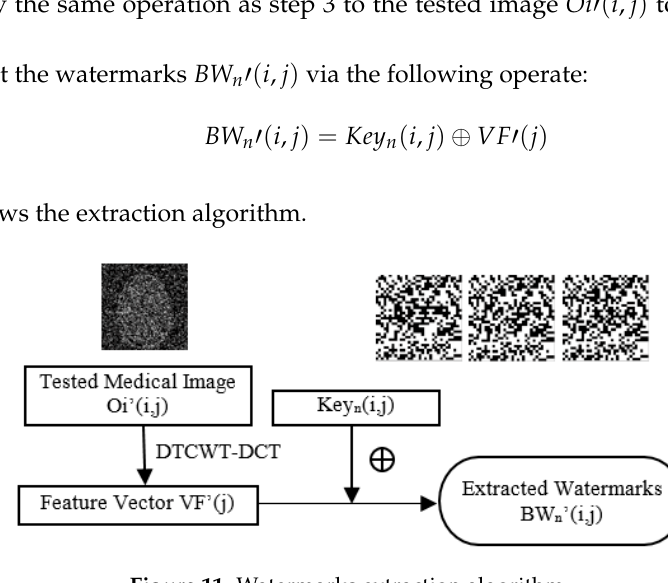
Figure 11. Watermarks extraction algorithm.